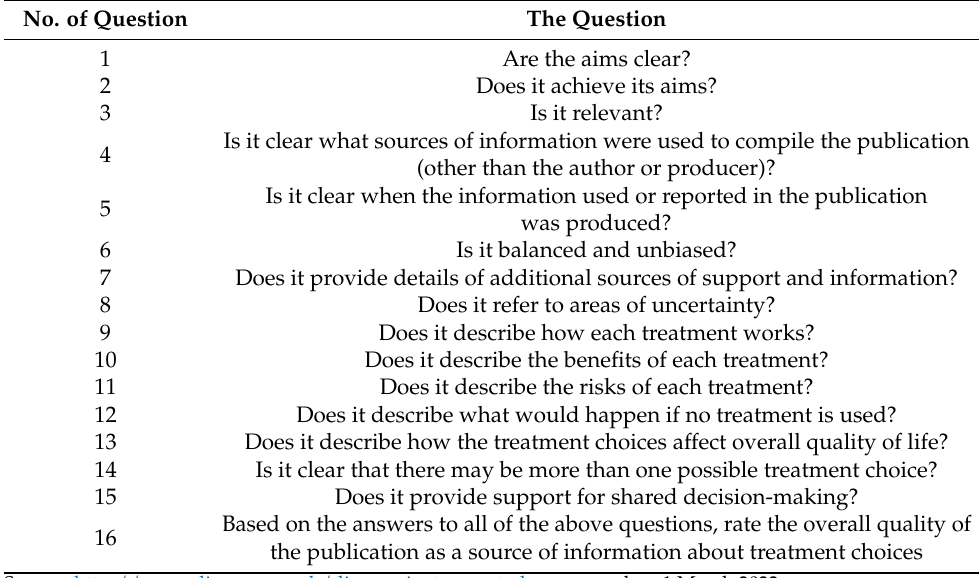
Table 1. DISCERN instrument